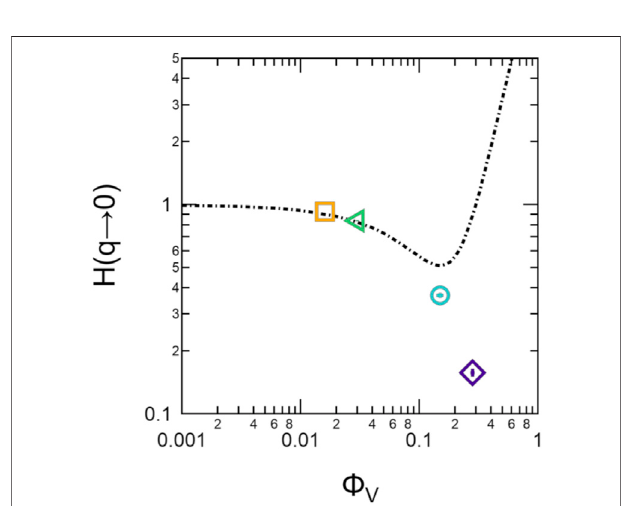
FIGURE 5 | Extrapolated H ( q → 0) values for the lipid vesicle solutions (points) compared to the hard sphere behavior described by Eq. 18 (dotted line). Error bars represent one standard